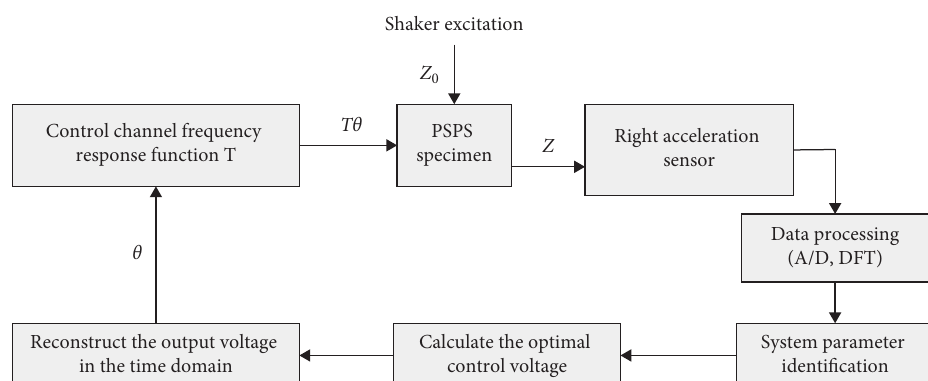
Figure 25: ASAC control flow